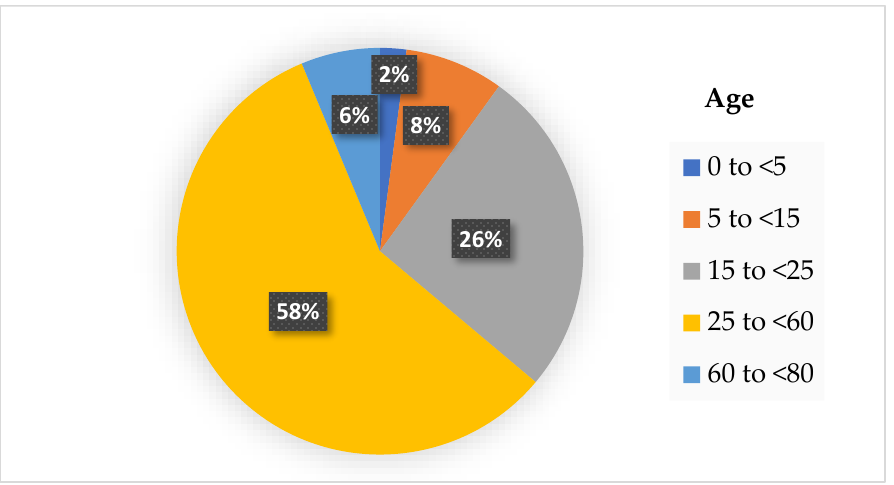
Figure 2. The percentage of COVID-19 infection cases based on age difference with reduced mobil- ity.